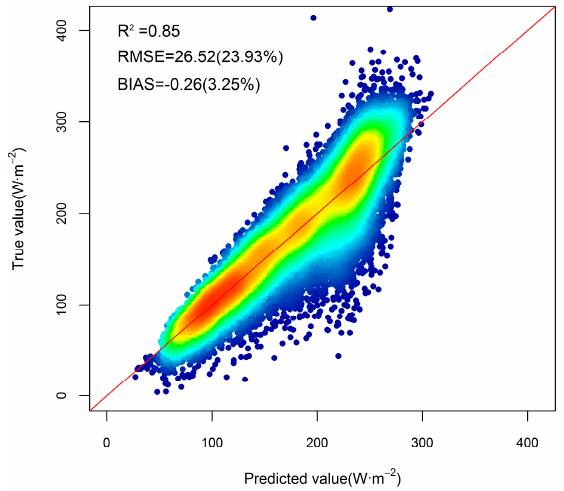
Figure 7. Validation results of the estimated daily DSR based on the GBRT model under clear sky conditions without considering Advanced Very High Resolution Radiometer (AVHRR) channels 4 and 5 as the input variables. The number in the parentheses is the percent bias or RMSE value.